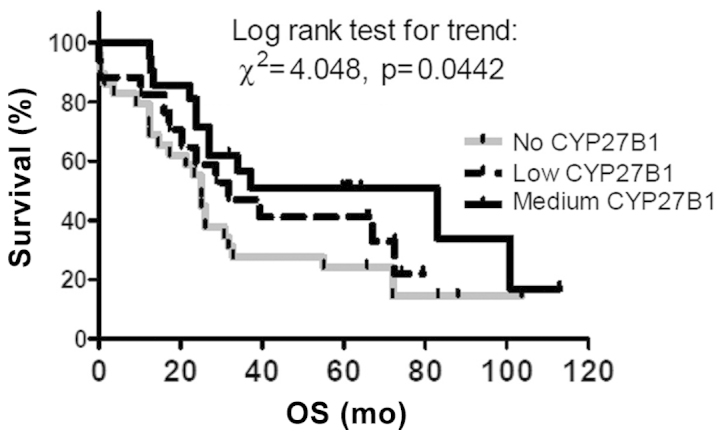
Lack of CYP27B1 in ovarian cancers is associated with shorter OS. OS, overall survival.